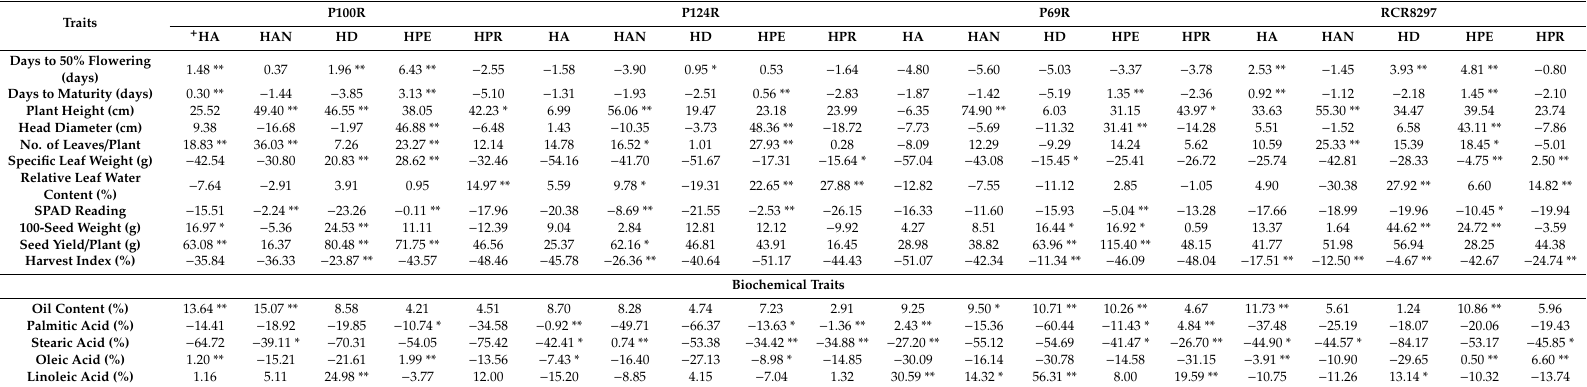
Table 2. Heterosis over better-parent values (BPH, %) among CMS sources representing five di ff erent species of sunflower for morphophysiological, yield, and biochemical traits under the water stress